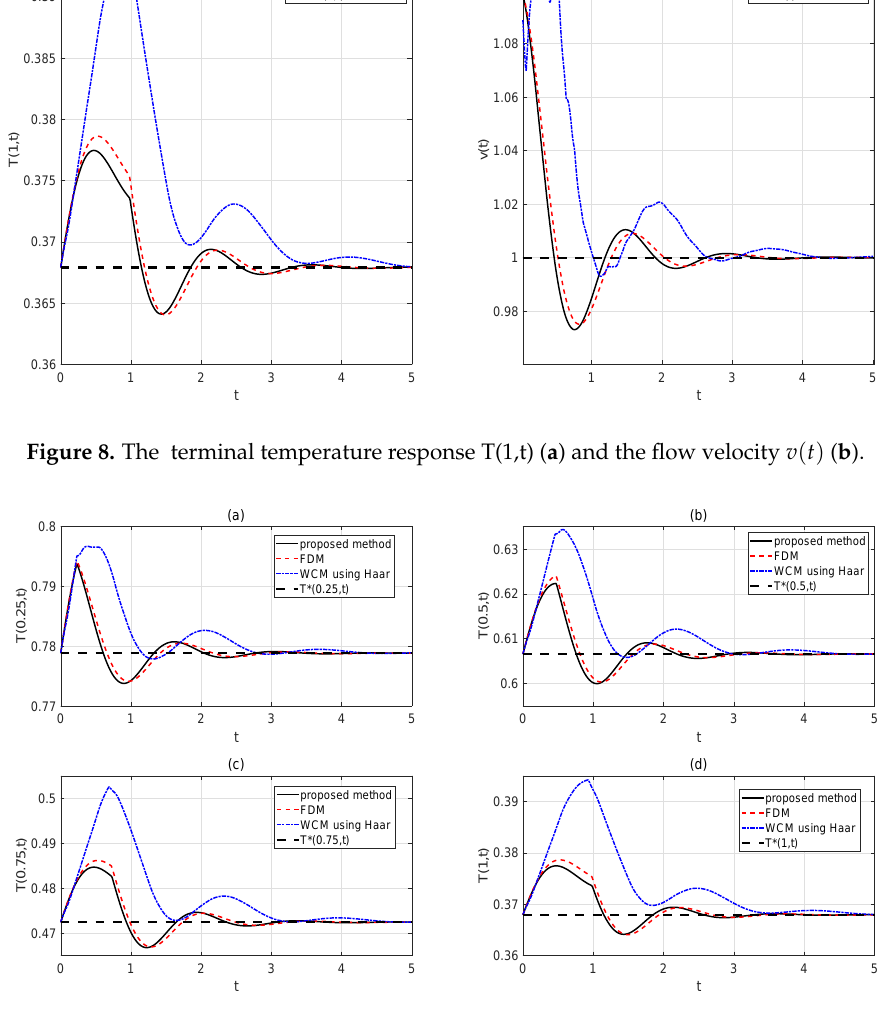
Figure 9. The performance of the controllers. ( a ) The temperature response at x = 0.25; ( b ) The temperature response at x = 0.5; ( c ) The temperature response at x = 0.75; ( d ) The temperature response at x =